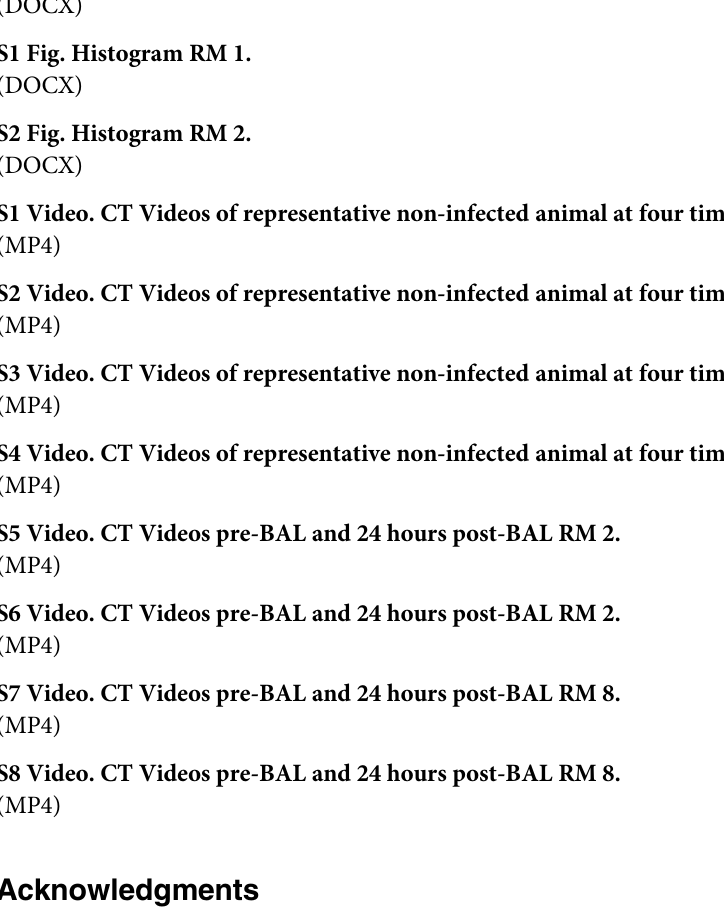
S2 Table. Overview of the CT scores of the non-infected macaques. S3 Table. Overview of the CT scores of SARS-CoV-2 infected macaques.